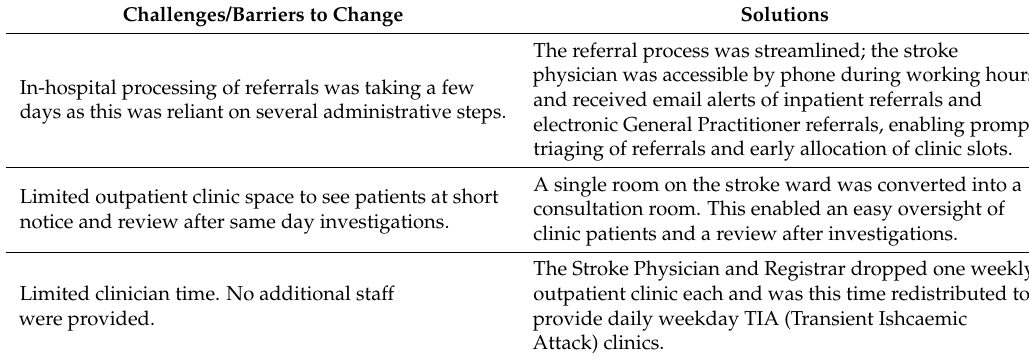
Table 1. Challenges faced by the service improvement project and how solutions were